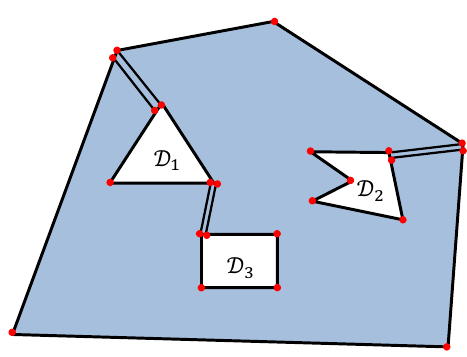
Figure 3. The construction of polygon Q by adding k non-intersecting diagonals to the polygon P .